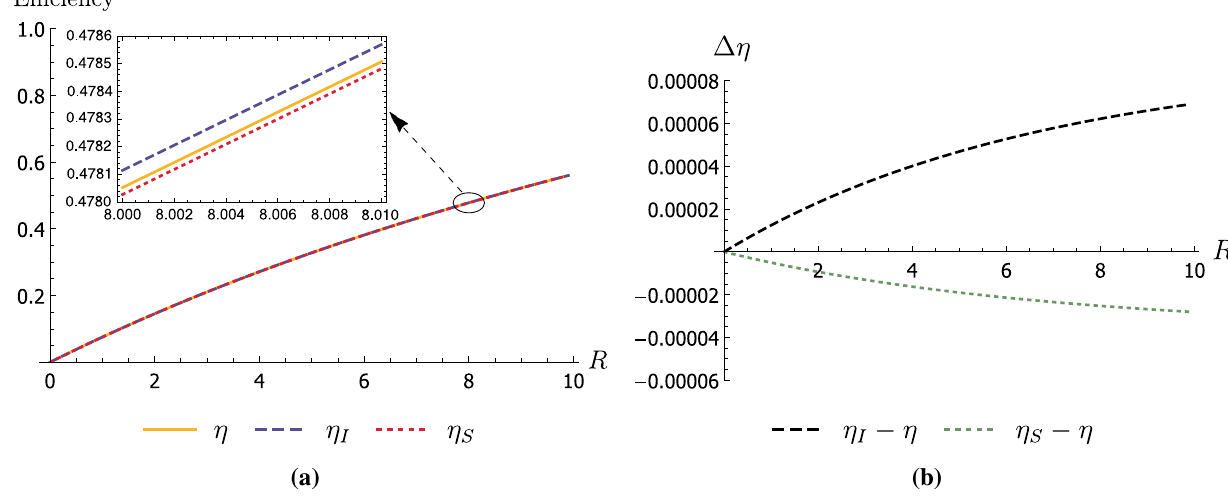
Fig. 4 a The efficiencies vs the radius R for three different families of black holes as the working material, including accelerating AdS (denoted by η with μ − = 0 . 2), the ideal gas (denoted by η I ) and Schwarzschild-AdS (denoted by η S ) black holes. The differences in the